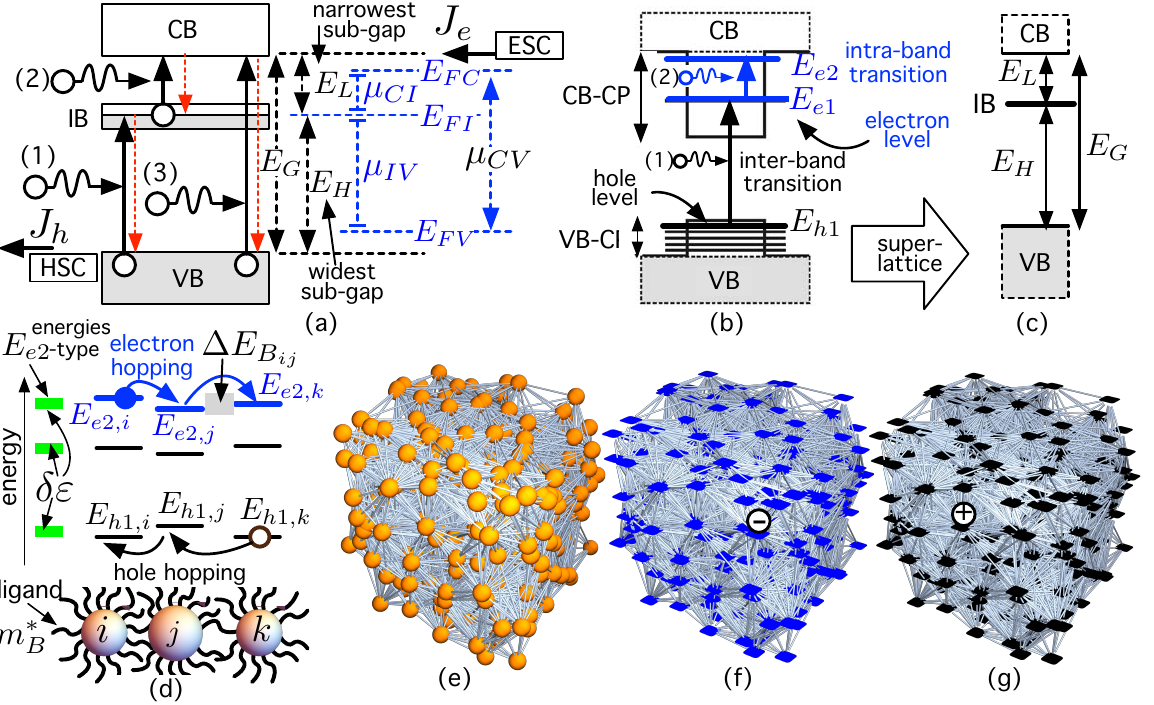
Figure 1. ( a ) Simplified illustration of the gaps and operation of an IBSC. ( b ) Single QD showing intra-band transition ( E e 1 → E e 2 ) and inter-band transition ( E h 1 → E e 1 ). ( c ) Resulting IB material. ( d ) Disorder causes electron hopping between localized states with different energy: E e 2, i → E e 2, j at QDs i and j . The same argument is applied to the case of hole hopping. δε and ∆ E B the energetic disorder and the barrier height between dots i and j . ( e ) CQD-network. ( f ) Network modeling electron hopping between E e 2 -type levels shown in ( d ). ( g ) Hole hopping network involving E h 1 -type levels shown in ( d ). See the main text for further